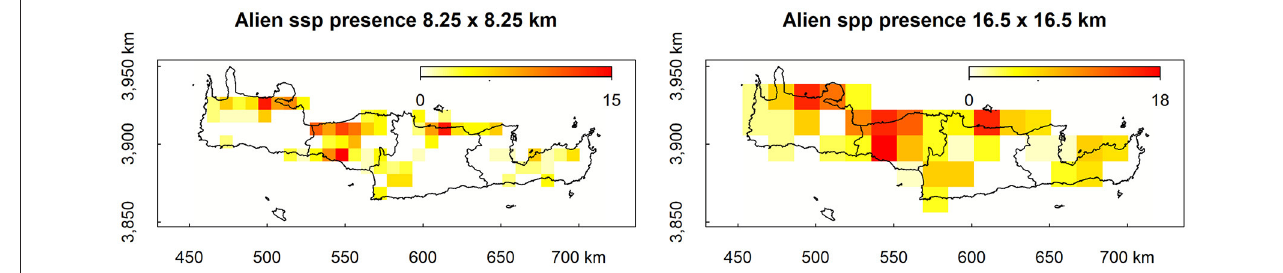
FIGURE 1 | Original (Left) and resampled (Right) spatial distribution of alien species presence in Crete.